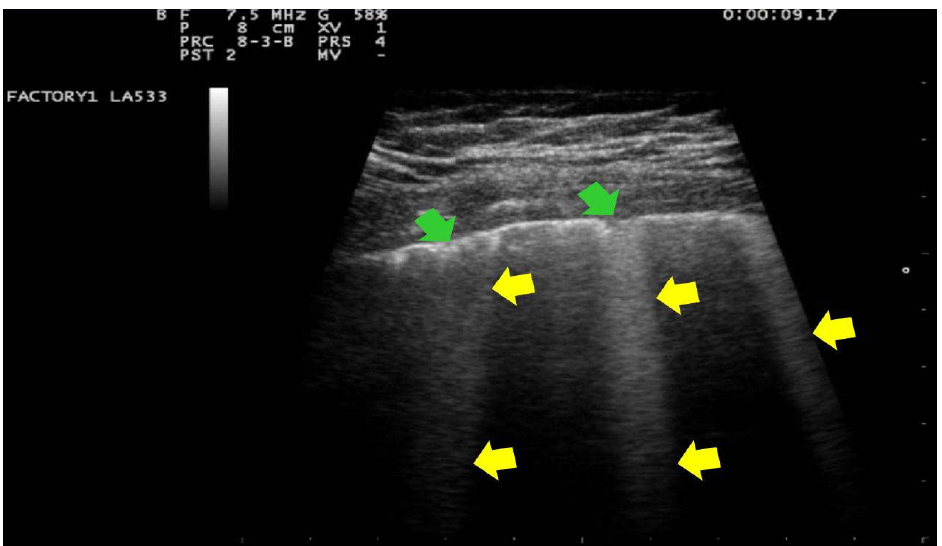
horizontal artifacts (A line), indicated by blue arrows, may be visible. This pattern is classified as score 0.